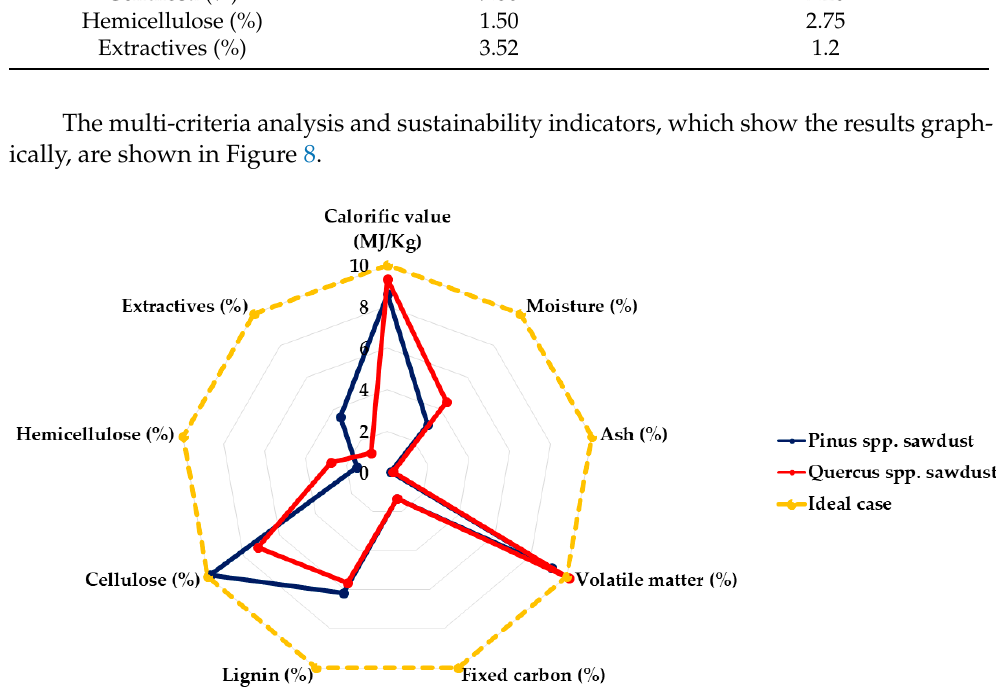
Figure 8. Formulation of indicators with different